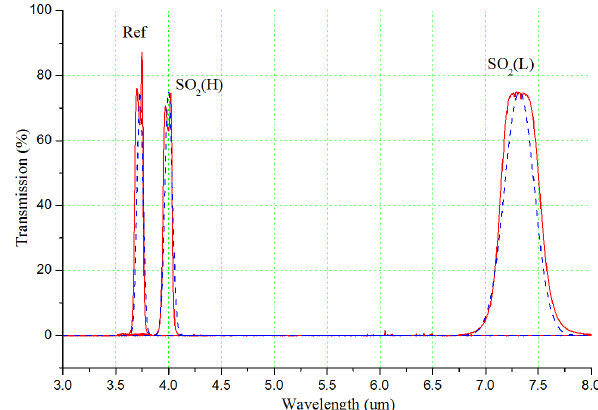
Figure 8. Linear correlation between measured and true concentra- tions. An excellent Pearson correlation coefficient r 2 of 0.99977 is